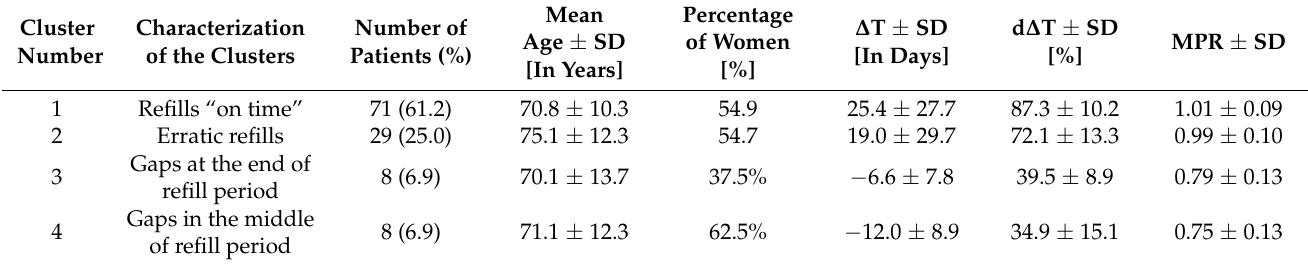
Figure 5. Heat maps replicating all 2204 ∆ T (19 refills × 116 patients) per refill number with green color indicating refill events “on time” ( ∆ T ≥ 0) and red color indicating events “too late” ( ∆ T < 0); ( A ) with a color gradient from +150 days (green) to − 150 days (red); ( B ) after dichotomization into green (“on time”) and red (“too late”); and ( C ) after clustering into the 4 refill groups: (1) refills are mostly “on time”, (2) erratic refills, (3) gaps at the end of the refill period, and (4) gaps in the middle of the refill period. Table 2. Characteristics of the four refill groups after clustering of the 2204 ∆ T values obtained from 19 refills from 116